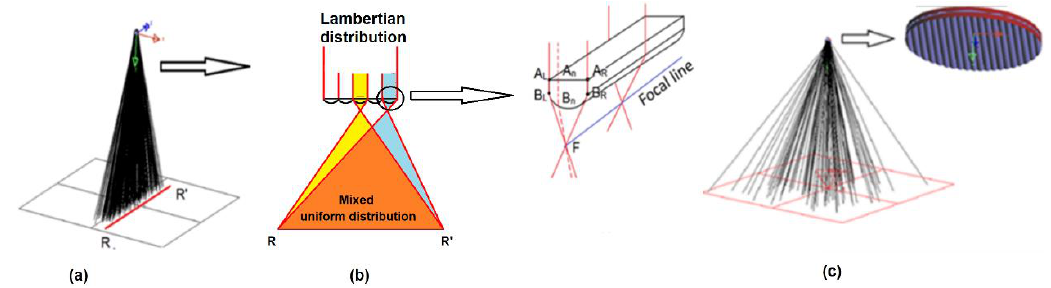
Figure 4. Design method of linear Fresnel lens ( a ) A single linear Fresnel lens redistributes light to a receiver. ( b ) Design for a segment of a linear Fresnel lens. ( c ) The lights were spread in two dimensions by double Fresnel lenses.